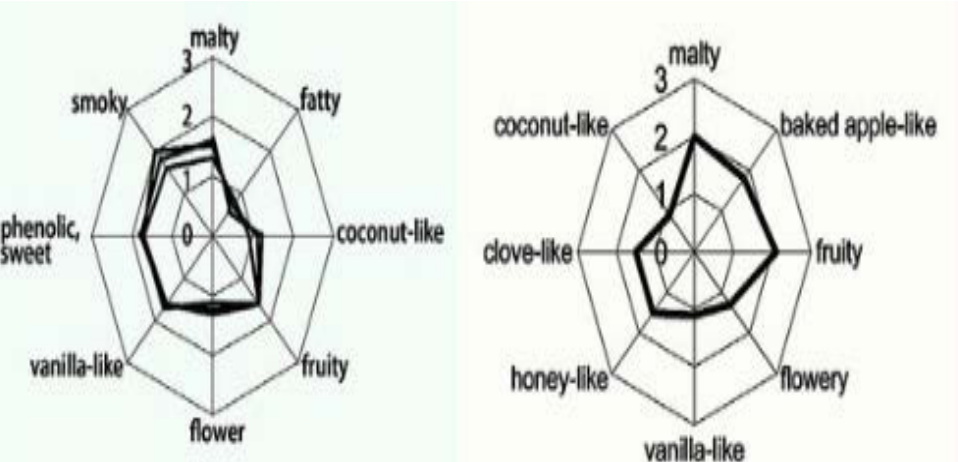
Figure 3. Spider diagrams of organoleptic characteristics in 2 experimental distillate